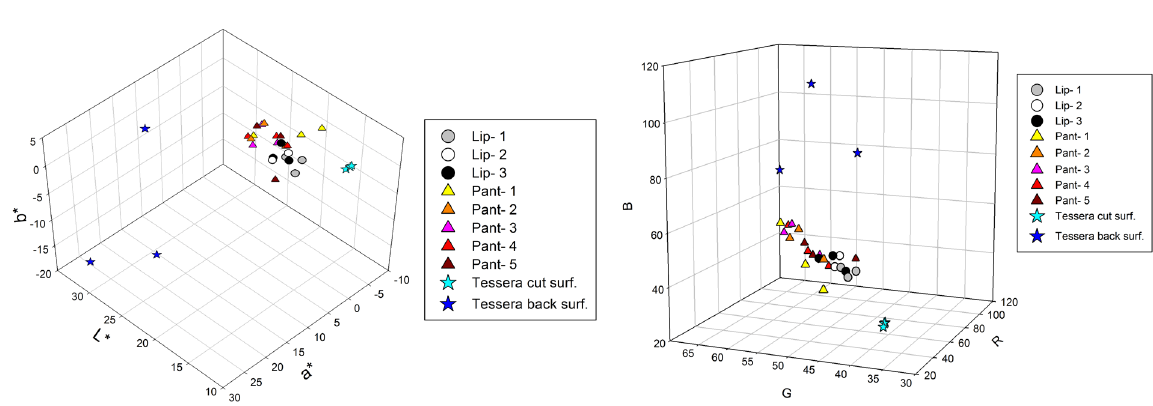
Figure 14: 3D plots of the colorimetric parameters L*, a*, b* (a) and RGB (b) measured on reference obsidian chunks from Lipari (Lip-) and Pantelleria (Pant-). The data are compared with the measures obtained from the surface of the sample MT-OS1-O1 after its cut from the origi- nal mosaic tessera, and the back surface of the